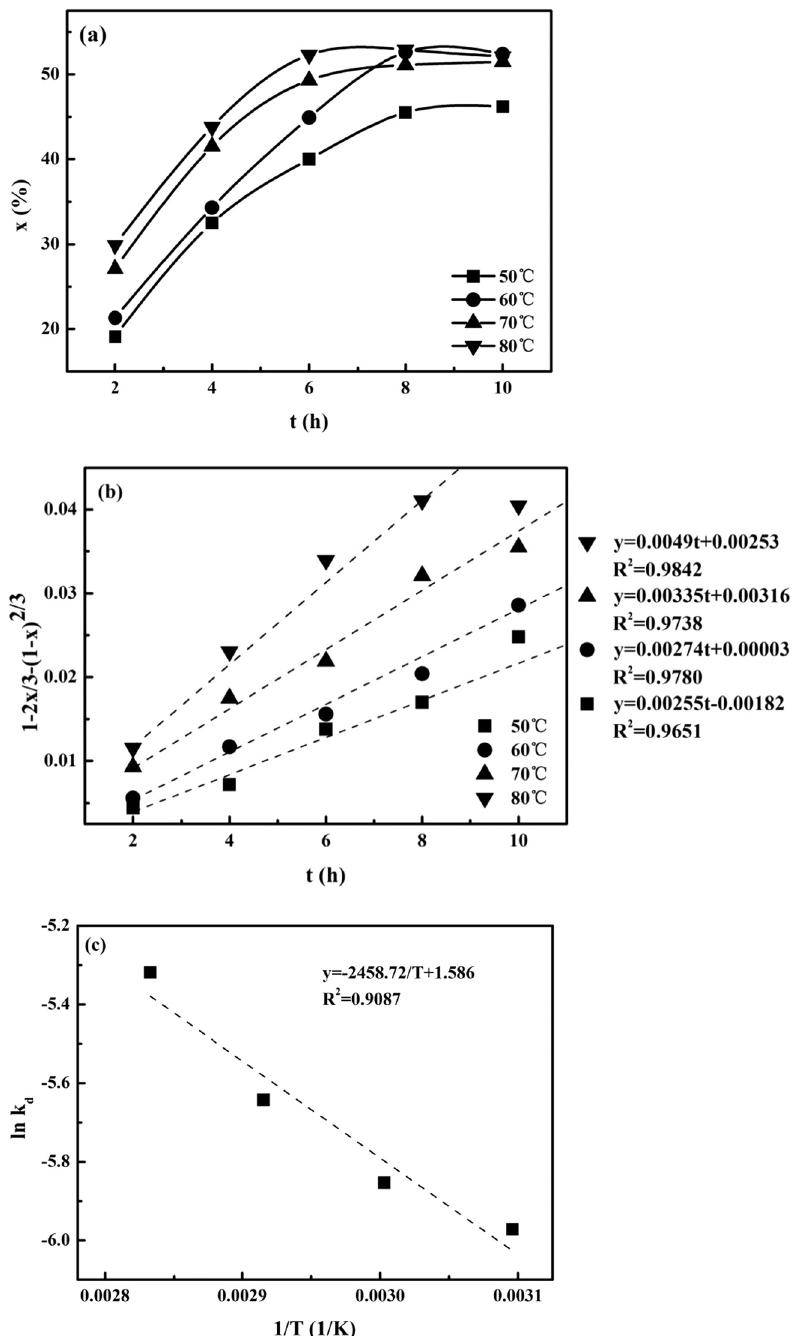
1 and k ln ( acid leaching conditions – H C O 2 3 and ( c ) d 3 T